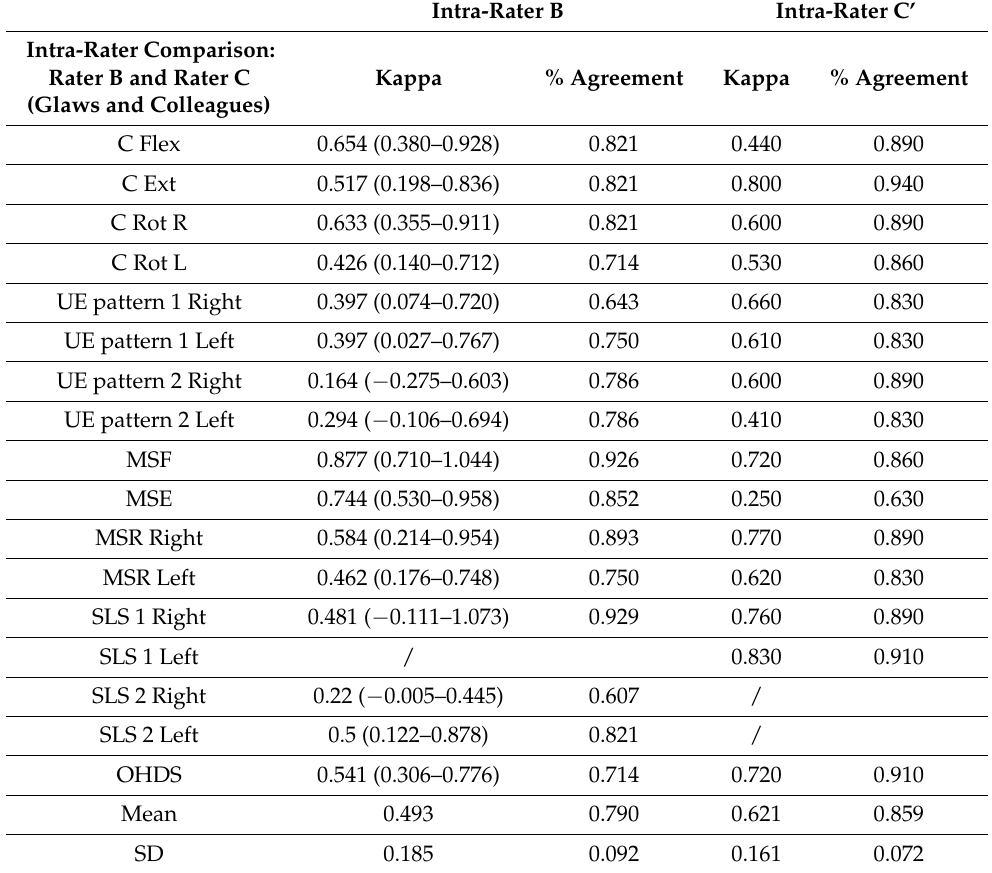
Table 2. Intra-rater reliability of rater